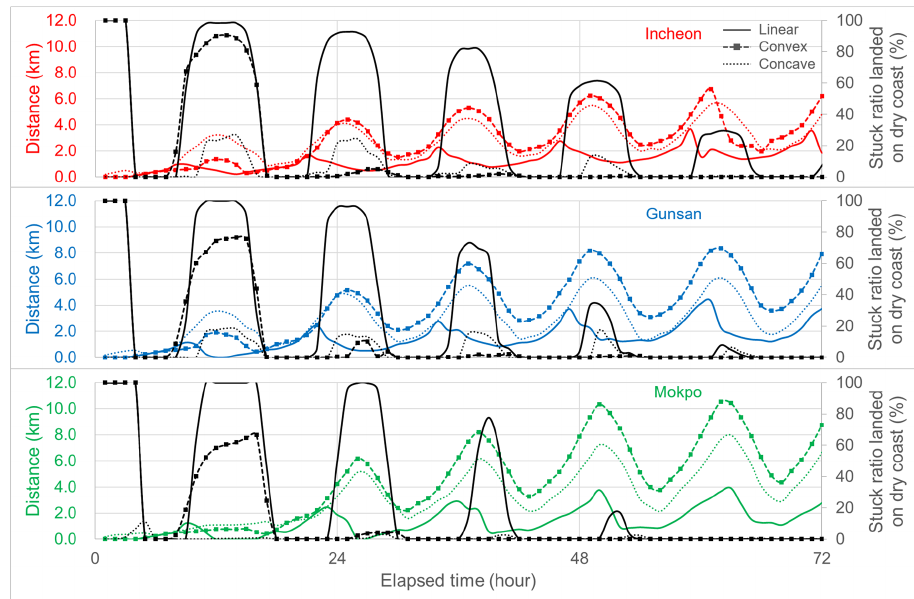
Figure 7. Temporal variation of particle movement (color solid and dotted lines) and stuck ratio landed on dry coast (black solid and dotted lines) with respect to bottom